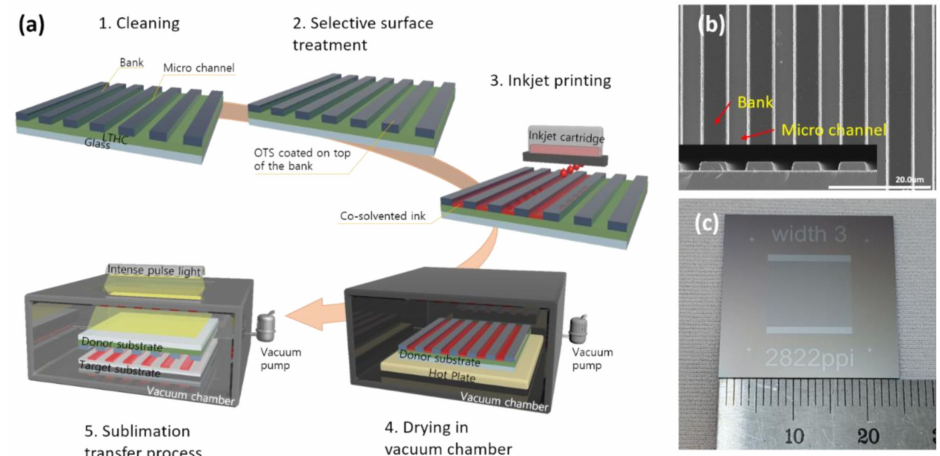
Figure 1. ( a ) Sequential schematic diagram of the patterning process by using inkjet printing grafted onto the sublimation transfer process. ( b ) SEM images of the LTHC substrate’s top and side views and ( c ) a picture of the LTHC donor